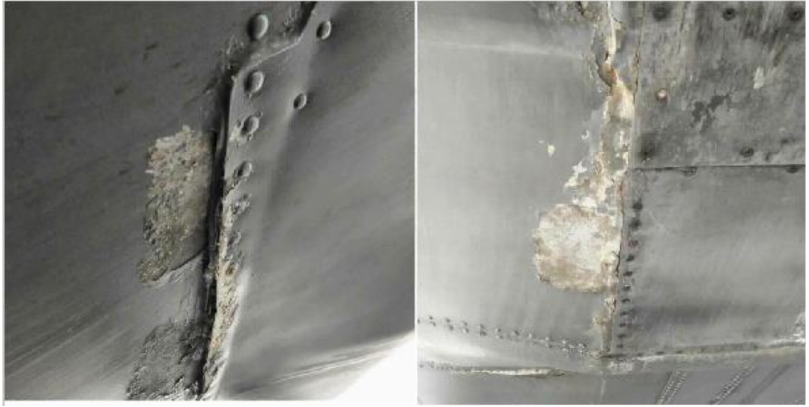
Figure 8. Corrosion at Lower Skin area.